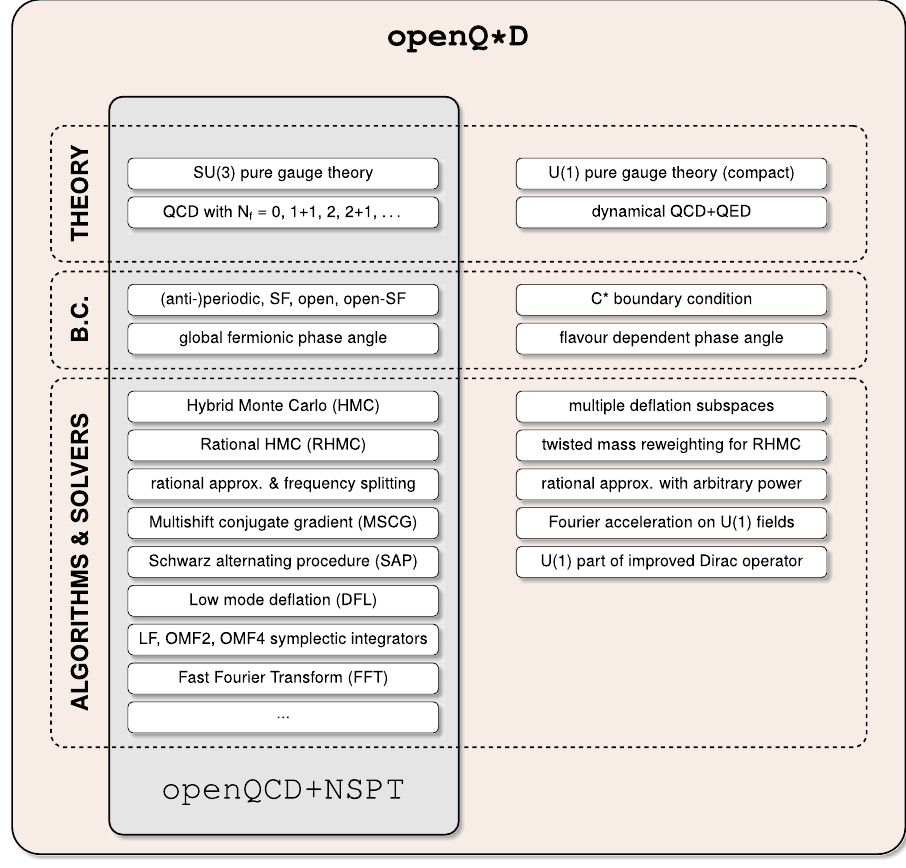
Fig. 1 Summary of salient features of openQ*D . Some features inherited from openQCD and NSPT are